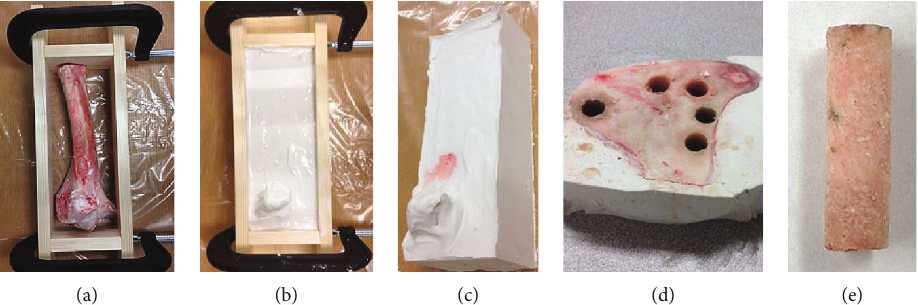
Figure 1: (a) Soft tissues were completely removed, and the bone was positioned in mold. (b) Mixed plaster of Paris was poured in. (c) After plaster consolidation, mold was removed. (d) The molded femur was transversely sliced in 30 mm thickness using a laser-guided mitre saw; bone specimens were cored from the slices using diamond coring bit of 8 mm diameter. (e) Information of each specimen, including animal, femur, anatomic site, and bone type, was recorded; the specimens were then labeled, wrapped with kitchen fi lm, put in air-tight plastic container, and then stored in the freezer (-20 ° ) before testing.